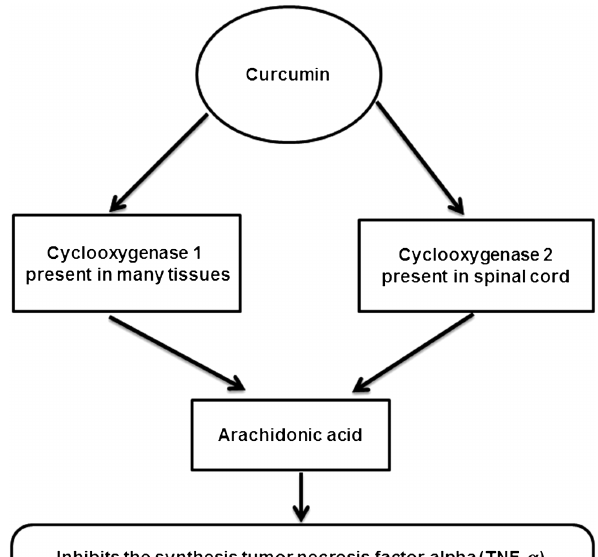
Figure 6: Anti-inflammatory action of